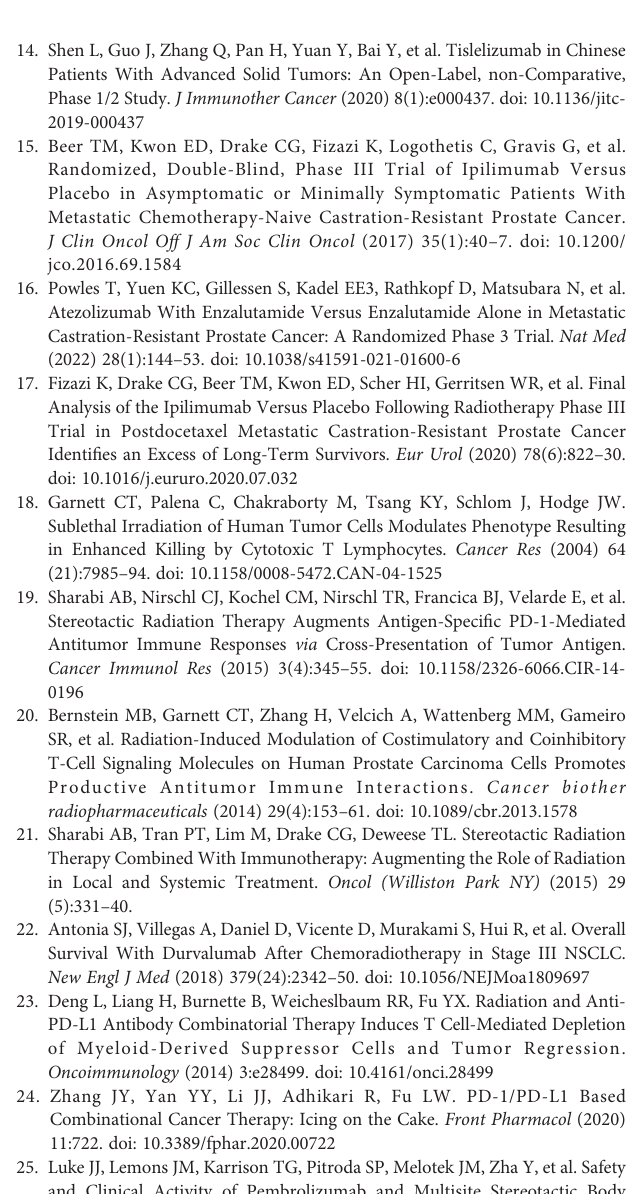
Supplementary Table 1 | Assessment timetable. In peripheral blood, the biomarkersandthemaindetectiontechniquesincludedimmunecellsandsubsets,such as CD 4+ T/CD 8+ T/Treg/MDSC/M1-TAM/M2-TAM (FCM); TMB (NGS). PSA , prostate- speci fi c antigen; AEs , adverse events; SAEs , serious adverse events; MMR ,